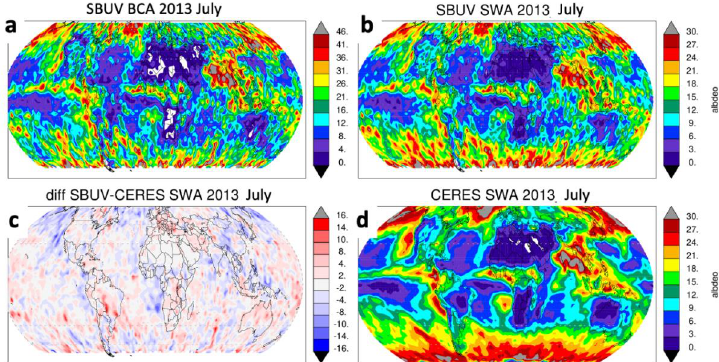
Figure 8. Map for July 2013 of ( a ) UV black-sky cloud albedo (%) from the SBUV merged product (NOAA-17 and -19 are the SBUV instruments operating at this time), ( b ) map of proxy-shortwave cloud albedo derived from UV BCA, ( d ) map of shortwave cloud albedo from CERES, ( c ) difference map of UV-derived proxy-SW cloud albedo (map ( b )) minus CERES SW cloud albedo (map ( d )).